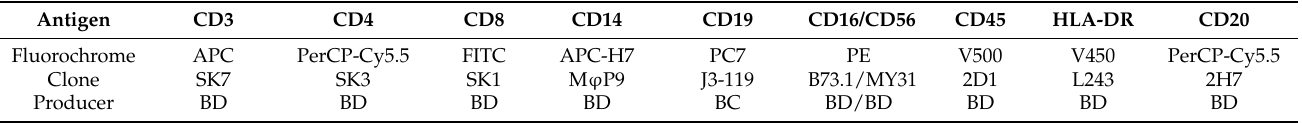
Table 1. Panel of antibodies used for flow